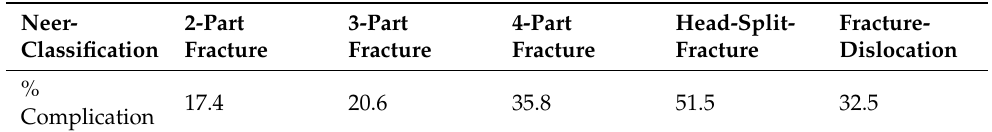
Table 5. Percentage frequencies of complication development in association with the fracture type of the Neer classification.